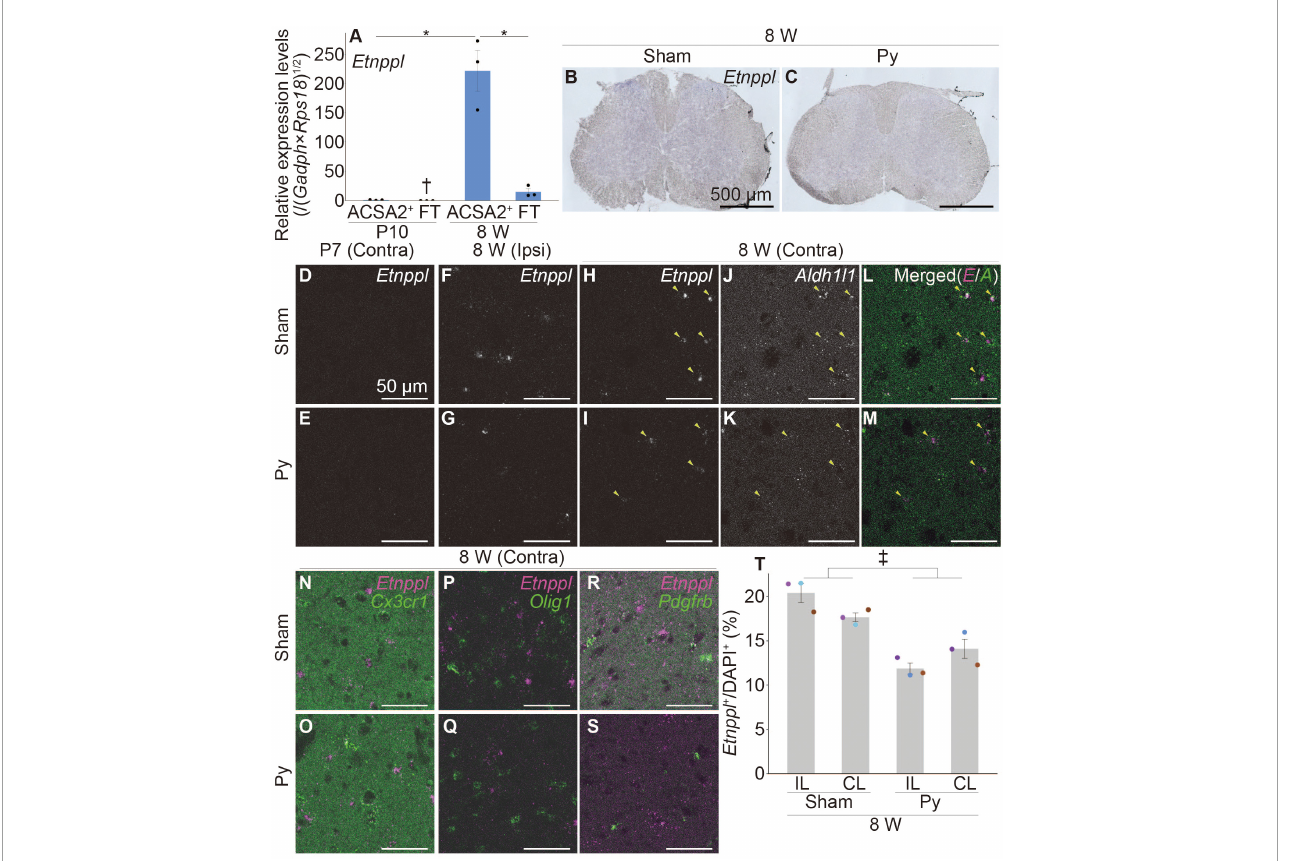
FIGURE1 Etnppl -expression in astrocytes in adult and its expression change after pyramidotomy. (A) Etnppl expression in MACS-isolated ACSA2 + astrocytes. The vertical axis represents the relative expression level of Etnppl normalized by the geometric mean of glyceraldehyde-3-phosphate dehydrogenase ( Gapdh ) and ribosomal protein S18 ( Rps18 ), taking the value of the ACSA2 + P10 sample as one. Mean ± S.E.M. n = 3, * P < 0.05, Tukey’s HSD test; † below the limit of quantification. FT, flow-through. (B,C) Localization of Etnppl , as revealed by ISH. Cervical cord of 8 W female mice 3 days after sham surgery (B) or pyramidotomy (C) are shown. The Etnppl signal is indicated by blue and purple. The right side is marked with black pigment. Dorsal is top, left is to the left. Scale bars: 500 µ m. (D–S) Localization of Etnppl and other cell markers revealed by RNAscope. Confocal enlarged images of gray matter of the contralateral (D,E,H–S) or ipsilateral (F,G) side of the cervical cord of female mice that were subjected to sham surgery (D,F,H,J,L,N,P,R) or pyramidotomy (E,G,I,K,M,O,Q,S) at P7 (D,E) or 8 W (F–S) 3 days before fixation. White indicates the signal for Etnppl (D–I) or Aldh1l1 (J,K) . Magenta in the merged images (L–S) indicates the Etnppl signal. Green indicates signals for Aldh1l1 (L,M) , Cx3cr1 (N,O) , Olig1 (P,Q) , or Pdgfrb (R,S) . Yellow arrowheads indicate Etnppl - Aldh1l1 double positive cells. Scale bars: 50 µ m. (T) Quantification of Etnppl + cells. The vertical axis represents the percentage of Etnppl + cells among all cells (DAPI + ). Mean ± S.E.M. n = 3 individuals, each of which is an average of 3–4 different sections. ‡ P < 0.05, Sham vs. Py; P < 0.05, interaction effect; two-way ANOVA; IL, ipsilateral; CL, contralateral. The same color indicates the same